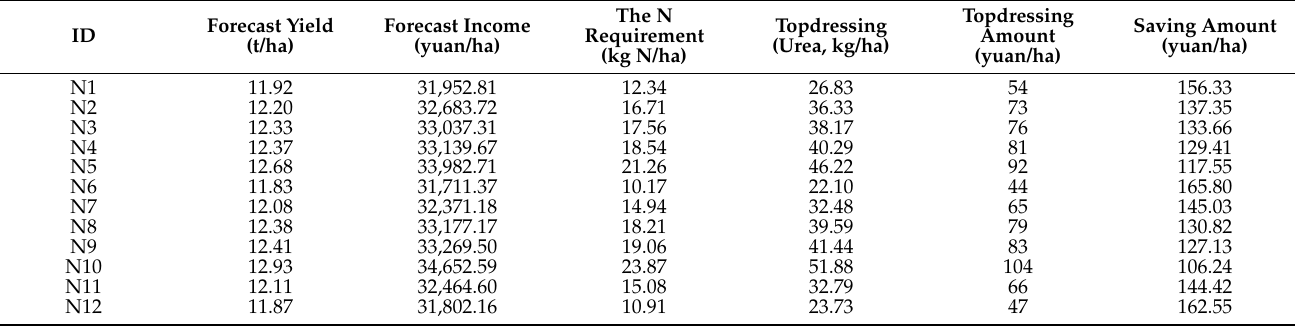
Table 6. Income forecast and top-dressing expenses of each